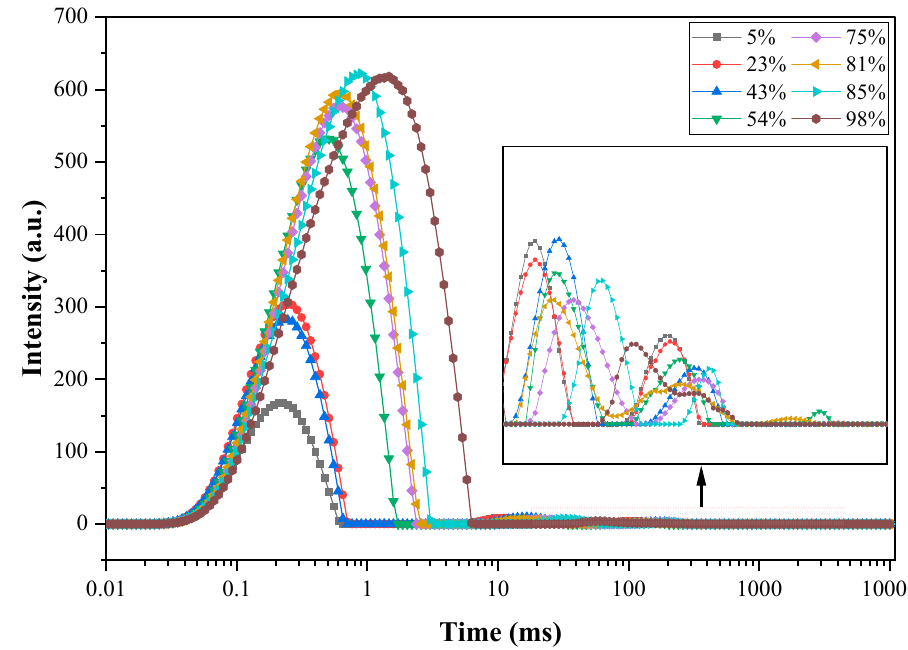
Figure 3. T 2 relaxation spectra of samples cured at different ambient RH.